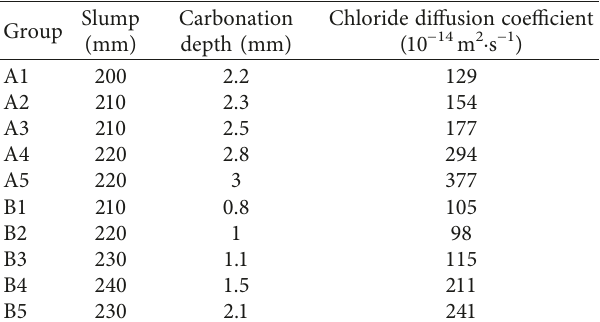
Table 4: Experiment results of